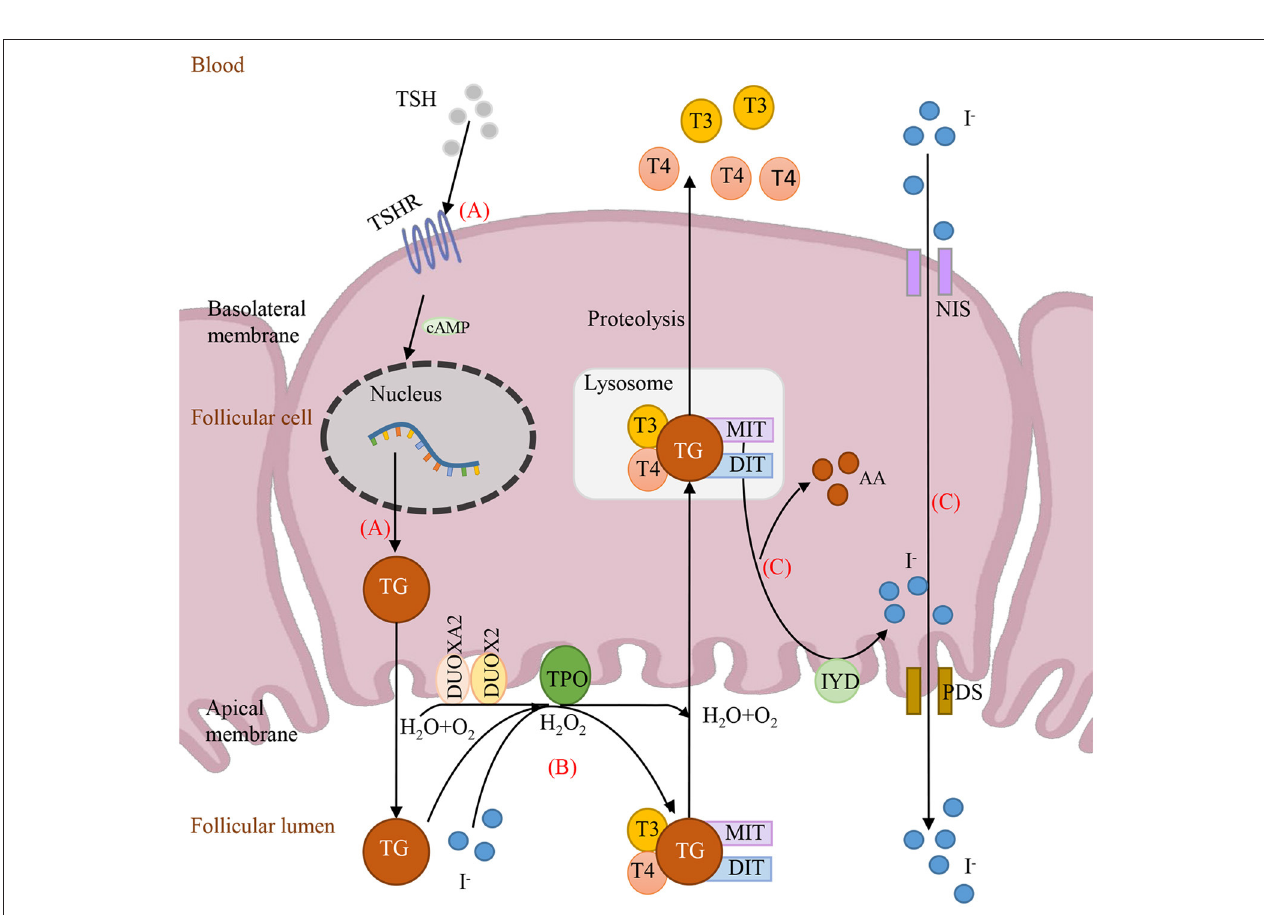
FIGURE 2 | Schematic depiction of the causative genes involving in thyroid hormone synthesis. (A) TSH binds to TSHR and then activates TG expression. (B) The iodide organification, with substrates TG and H 2 O 2 , which is completed by enzymes TPO, DUOX2 and DUOXA2. (C) Iodide recycled by IYD and transported by NIS and PDS. TSH, thyroid-stimulating hormone; T3, Triiodothyronine; T4, Thyroxine; MIT, monoiodotyrosine; DIT, diiodotyrosine; DUOX2, dual oxidase 2; DUOXA2, dual oxidase maturation factor 2; TSHR, TSH receptor; TG, thyroglobulin; TPO, thyroid peroxidase; AA, amino acid. involved in recycling of T4, T3, iodide and tyrosine